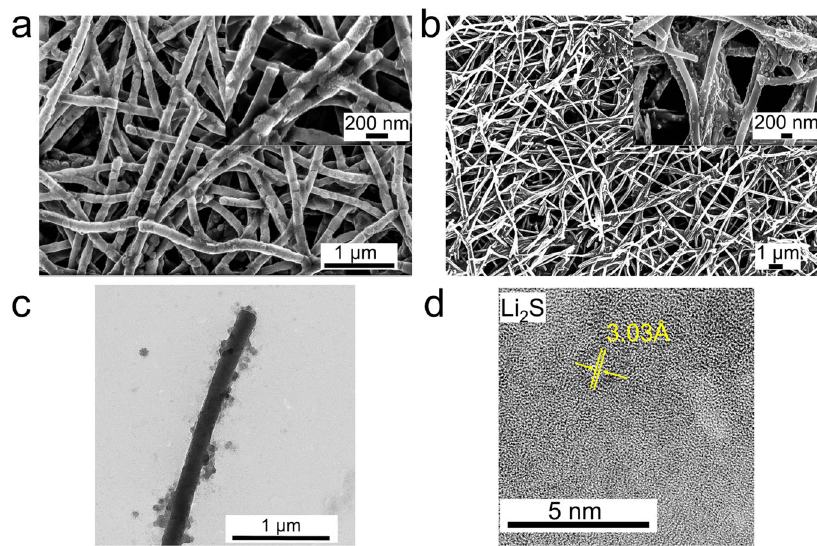
Fig. 6 Post-mortem SEM and TEM analysis of γ S-CNFs after charge – discharge cycles. a SEM images of γ S-CNFs after 20 discharge cycles. b SEM